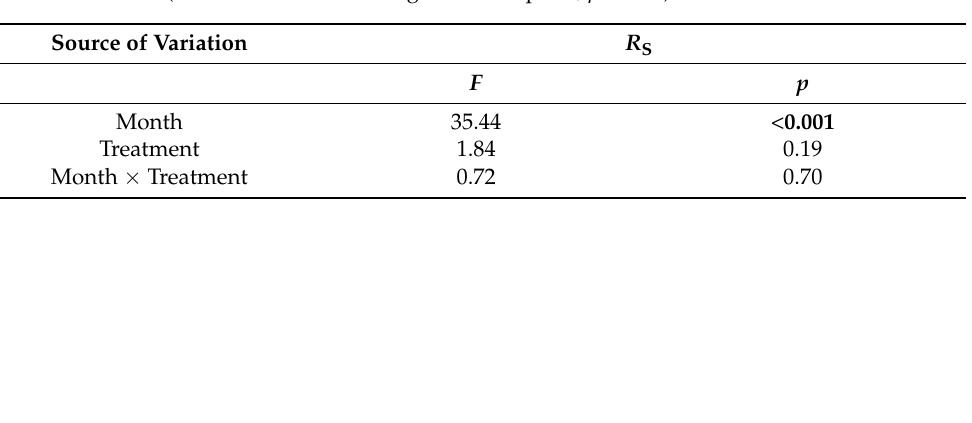
Table 2. Impacts of experimental treatment, month, and their interaction on R S tested by repeated measure ANOVA (bold numbers denote significant impacts, p <